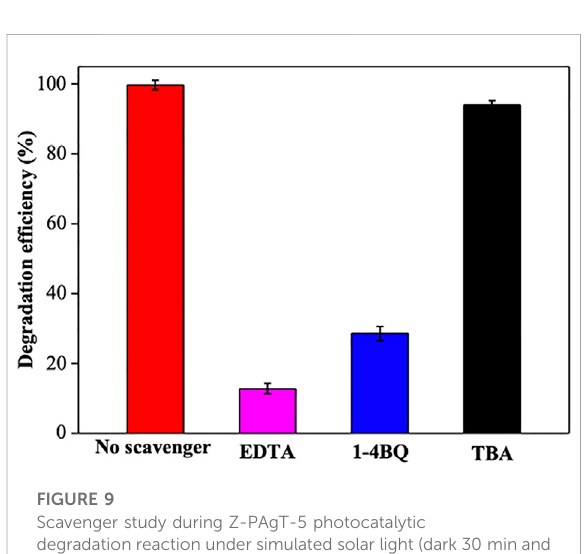
FIGURE 9 Scavenger study during Z-PAgT-5 photocatalytic degradation reaction under simulated solar light (dark 30 min and light 30